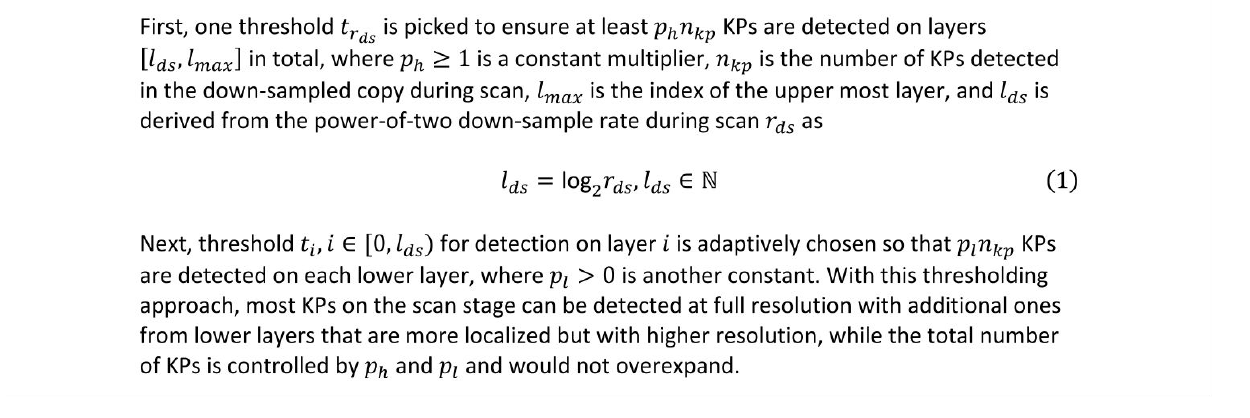
Figure 4. Adaptive thresholding in